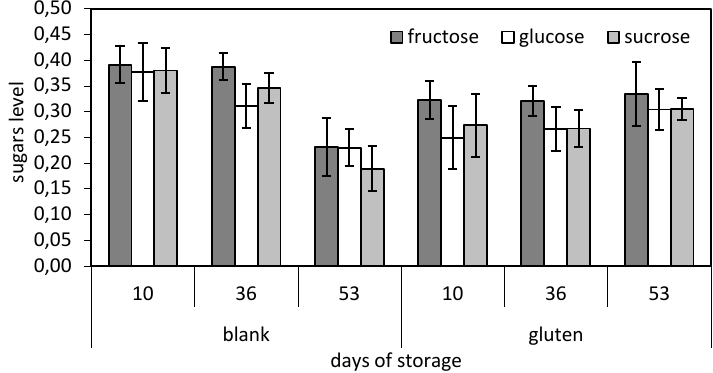
Figure 6. Low molecular sugar (fructose, glucose, sucrose) content comparison between samples made from white flour supplemented with 6% gluten and control samples.